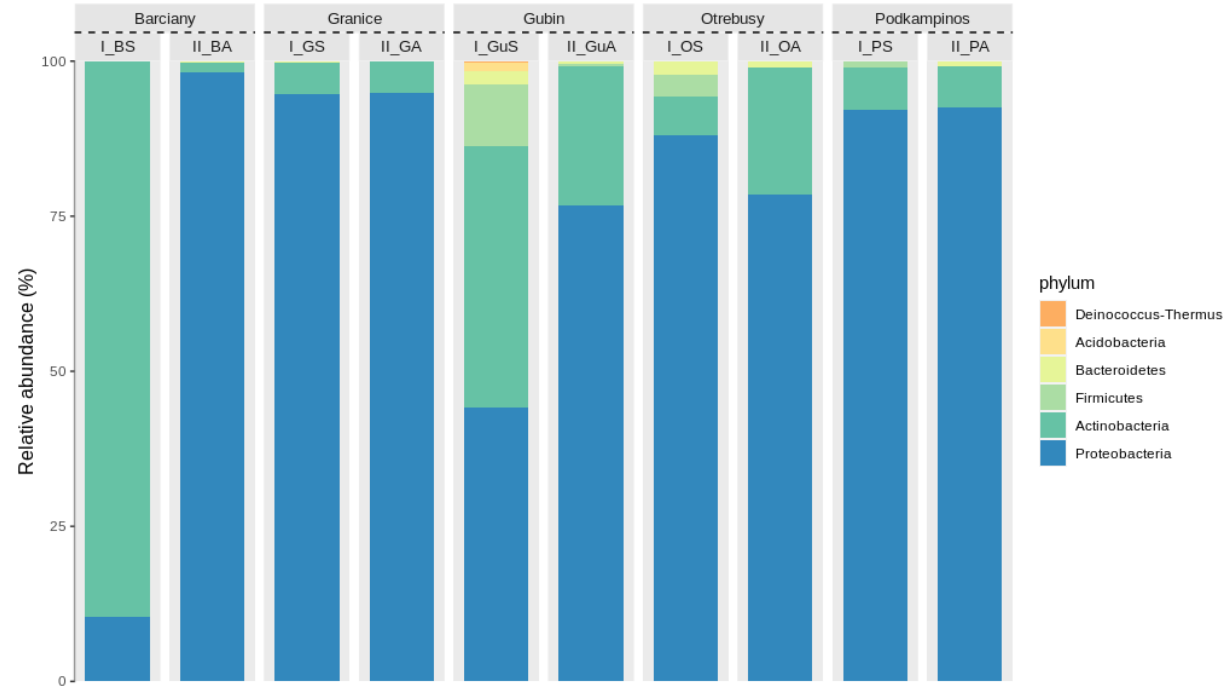
Figure 3. Histogram showing the relative abundance of the TOP six bacterial communities at the phylum level.